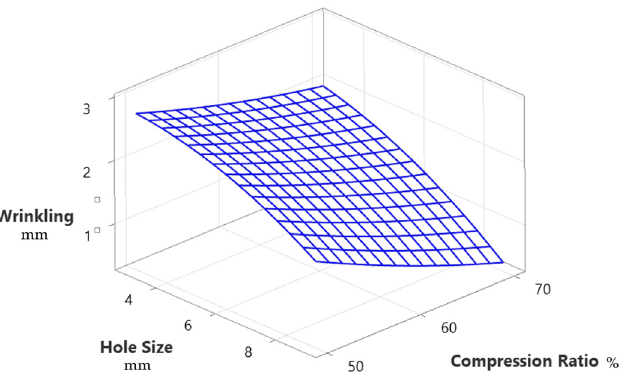
Figure 5. Effects of the hole size (mm) and the compression ratio (%) on wrinkling (mm).